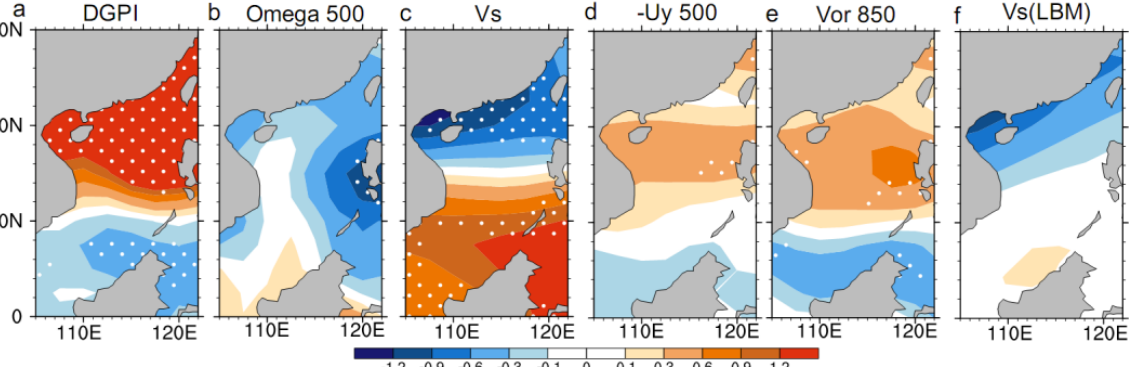
Figure 4. Composite differences in ( a ) dynamic genesis potential index, ( b ) 500 hPa vertical velocity (5 × 10 − 2 Pa s − 1 ), ( c ) vertical wind shear (4 m s − 1 ), ( d ) 500 hPa meridional gradient of zonal wind (10 − 5 s − 1 ), ( e ) 850 hPa absolute vorticity (10 − 5 s − 1 ) between the negative and positive RSTP years. White dots denote the significant values above the 90% confidence level. ( f ) The responses of the vertical wind shear (m s − 1 ) to cooling over the southeast TP in LBM.